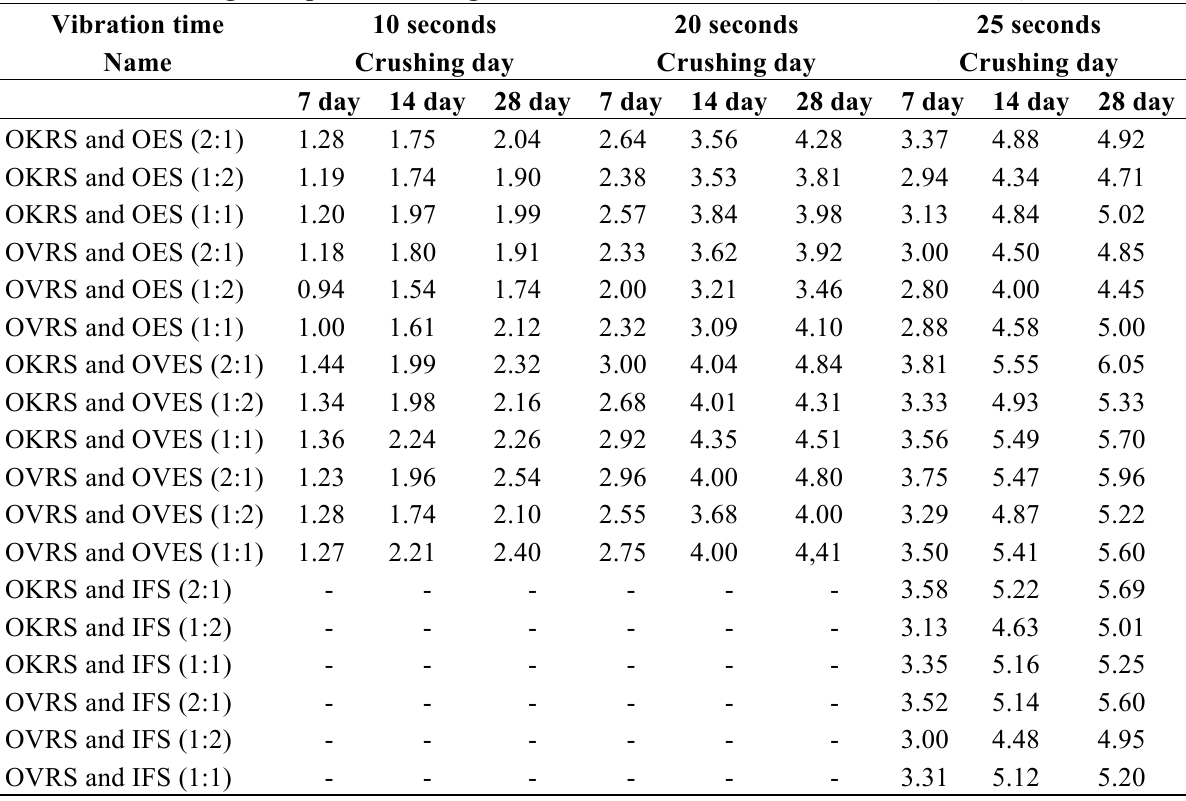
Table 10. Average compressive strength values for 225 mm sandcrete blocks from the various sand combinations and vibration